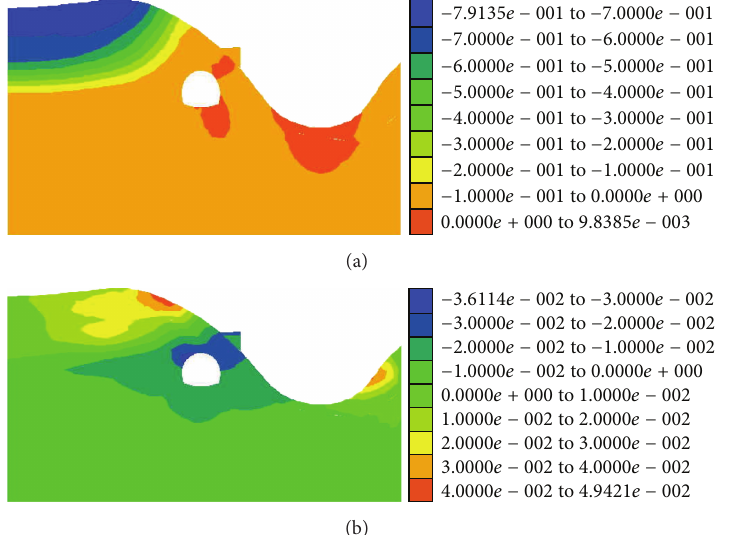
Figure 14: Displacements at section ZK49+883 when the influences of rainfall and creep were considered: (a) vertical displacement; (b) horizontal displacement.